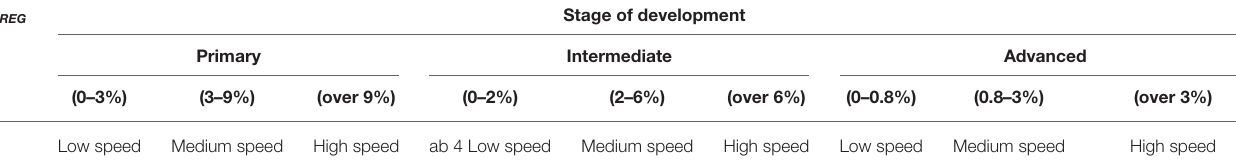
TABLE 6 | Evaluation criteria for green development of regional economy.